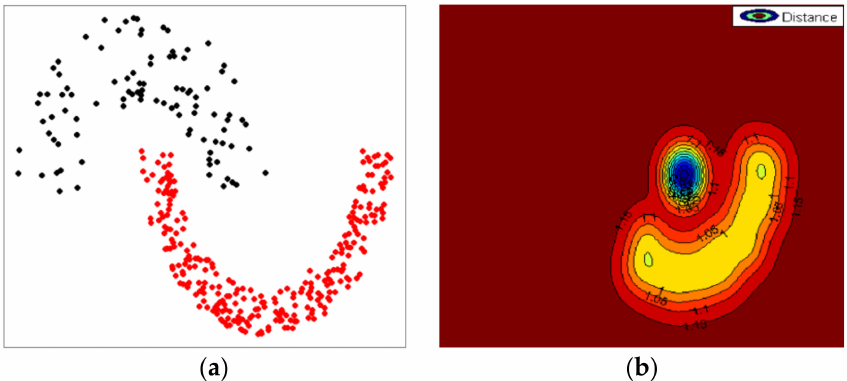
Figure 2. Visualization of kernel transformation: ( a ) asymmetry shape in original space; ( b ) trans- formed shape in feature